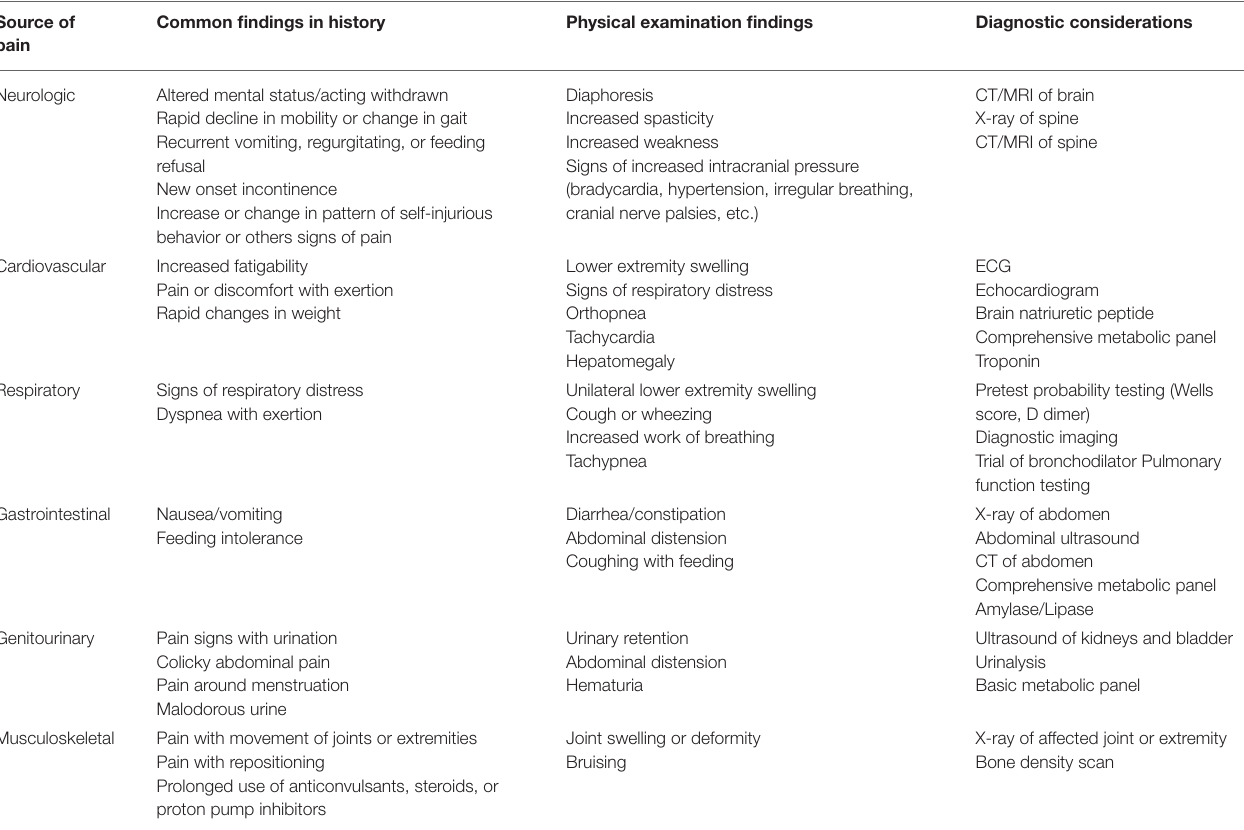
TABLE 1 | Findings in history and physical examination that may indicate pain as source of behavior change in adults with childhood-onset disabilities and communication impairment. Source of